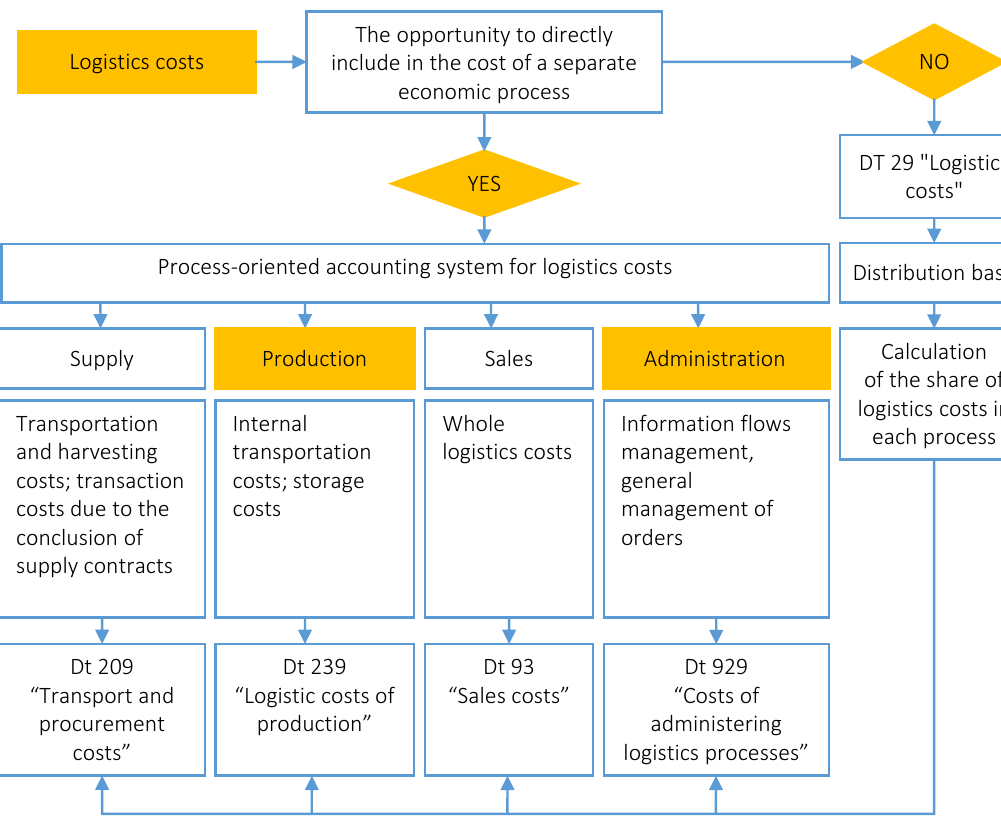
Figure 1. Algorithm for identification and recognition of logistics costs in